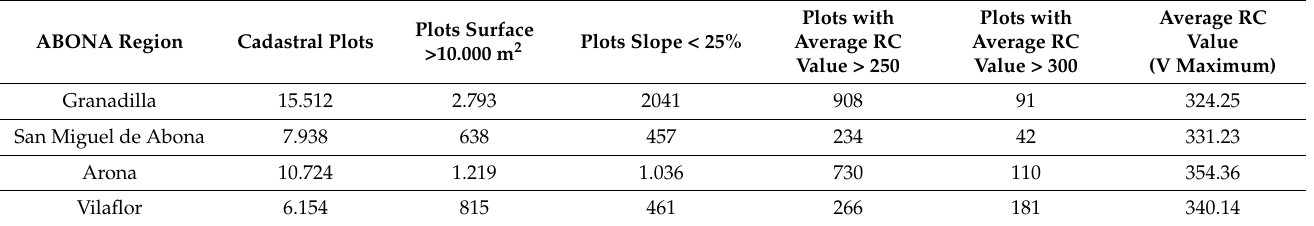
Table 3. Statistics relating to the cadastral plots by municipalities and regions (example of the Abona region).